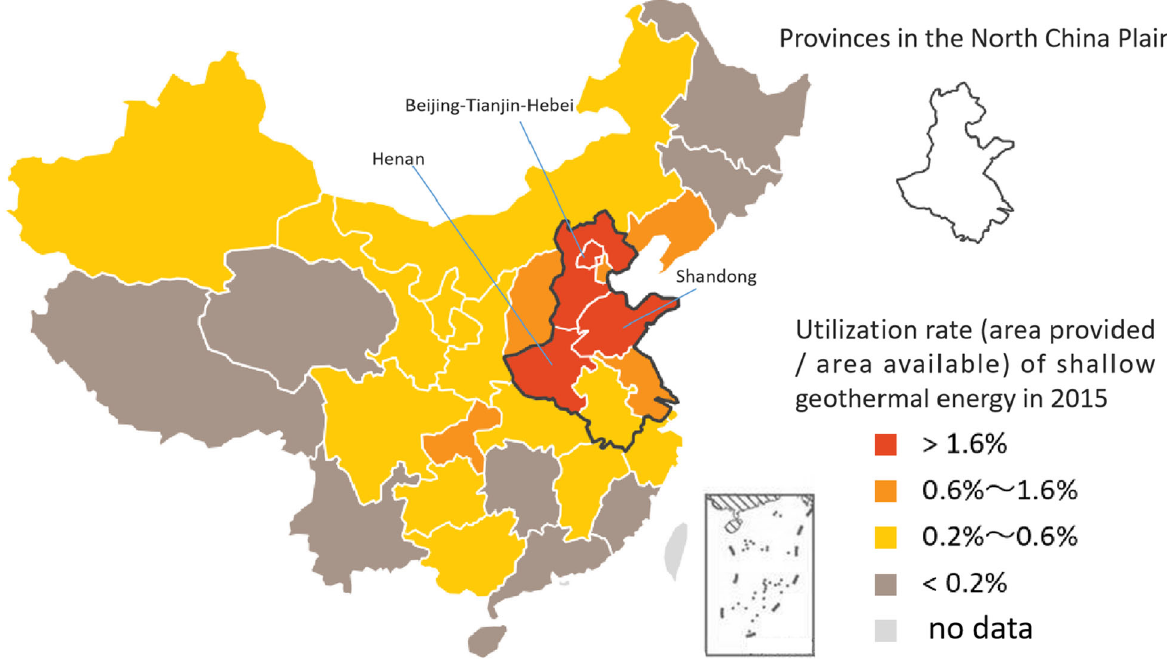
Fig. 6 Utilization rate of shallow geothermal energy [6]